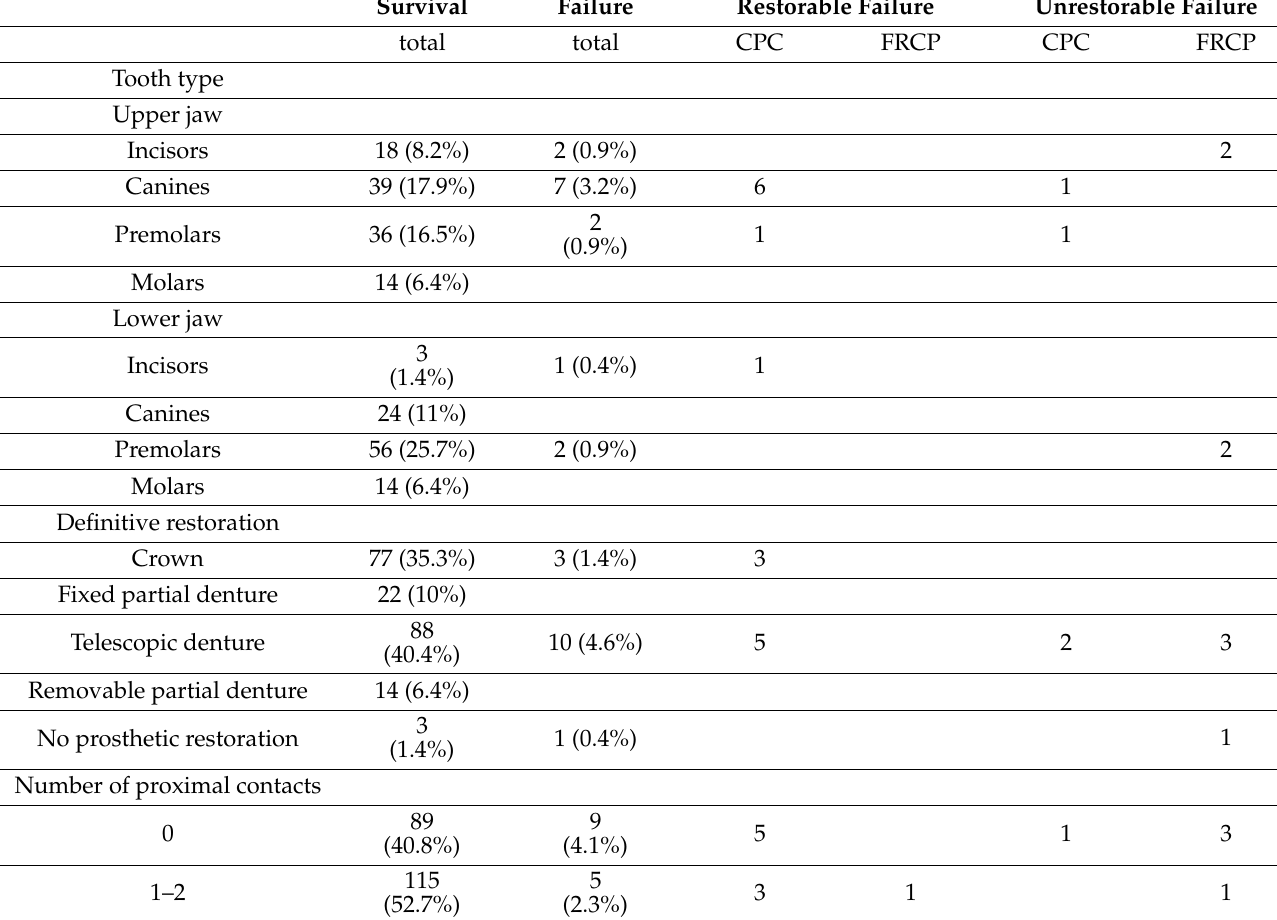
Table 3. Descriptive data